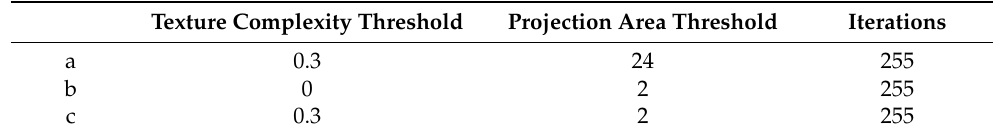
Table 1. Experimental Results with Different Figure 7. Results of the two views: ( a ) original image pair, ( b ) coarse mesh generated by the pair, ( c ) the result after refinement (grayscale rendering), ( d ) coarse mesh (color rendering), ( e ) refined result (color rendering).